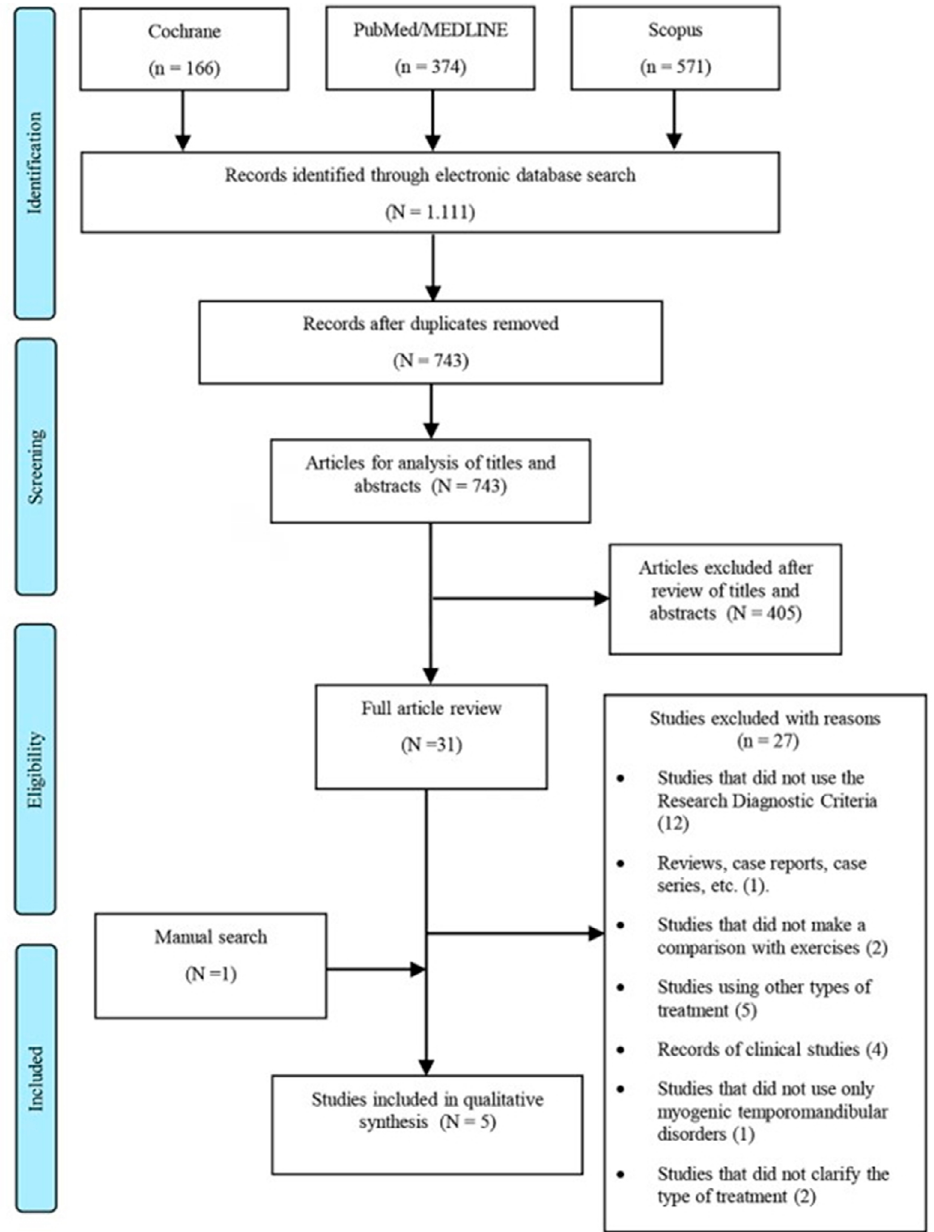
Figure 1- PRISMA flow diagram of study